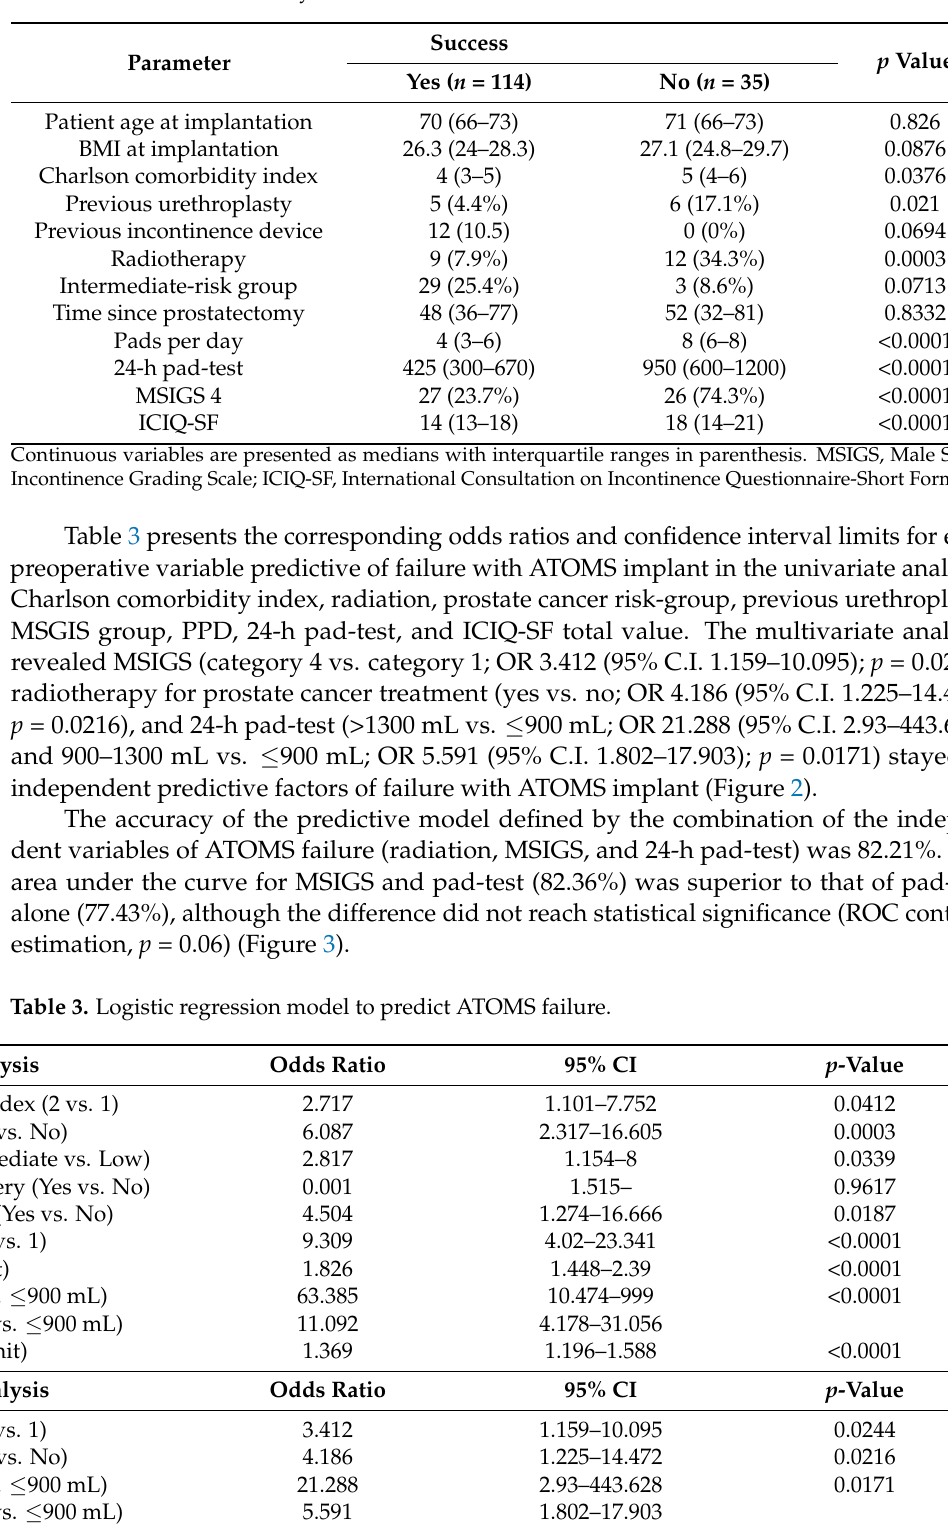
Table 2. Variables stratified by treatment success.